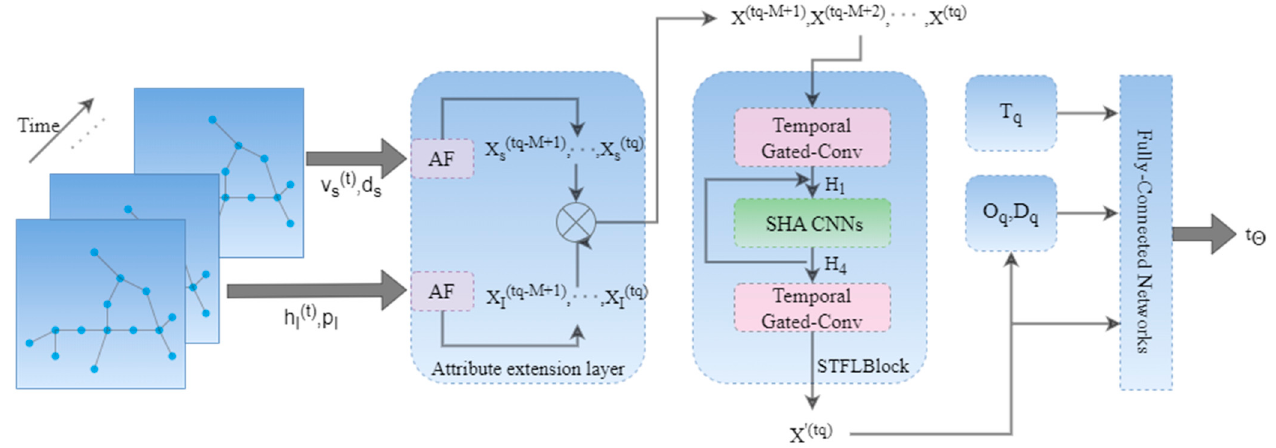
Figure 2. The overview of STHGNN.